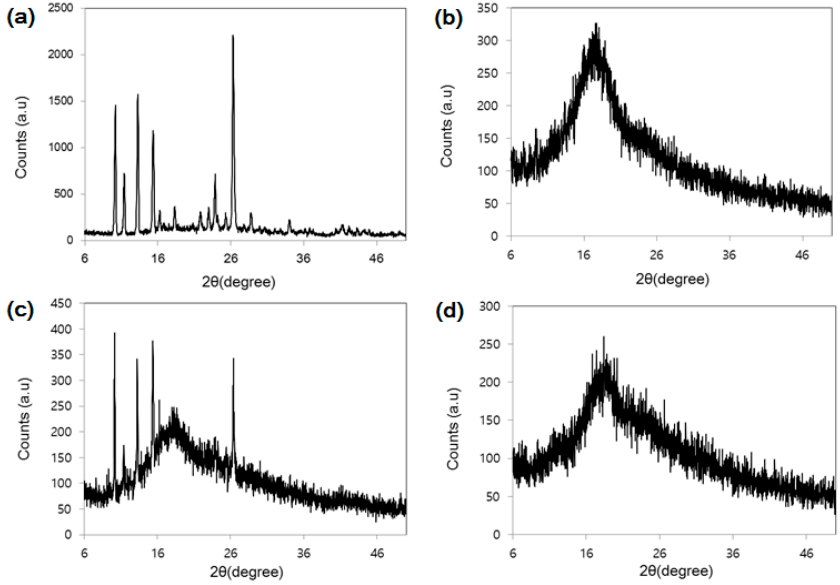
Figure 7. X-ray diffractograms. ( a ) Baicalein; ( b ) Cysteinyl β -CD; ( c ) Physical mixture; ( d ) Cysteinyl β -CD/baicalein inclusion complex.